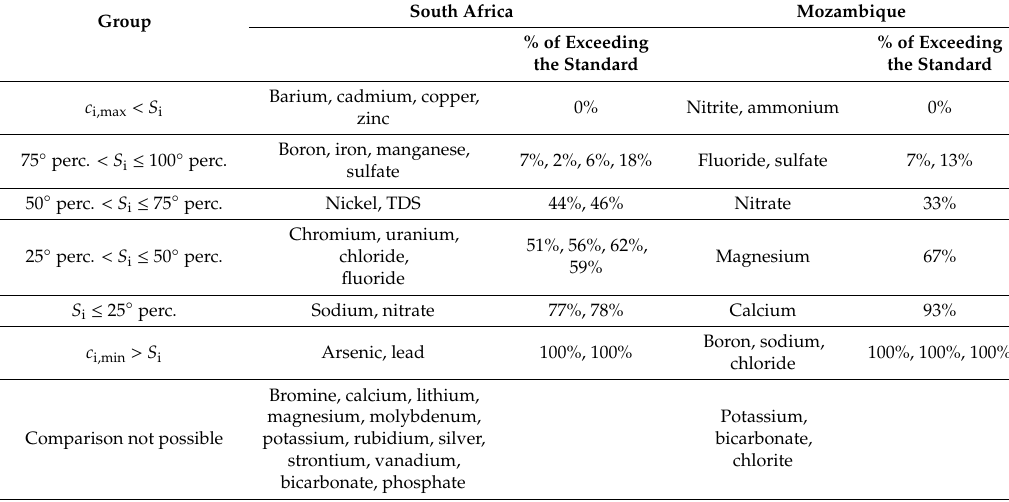
Table 5. Classification of the compounds occurring in groundwater, according to the Variability Range-Standard criteria (see Table 3) applied to specific South African and Mozambican regulations for drinking water (see Table 2).